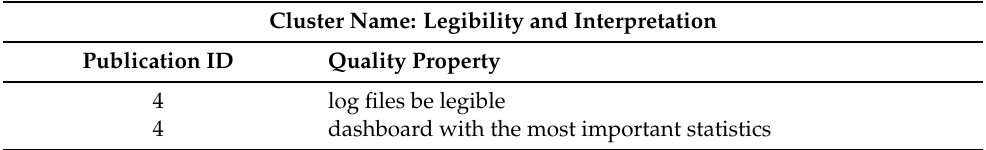
Table A8. Quality Property Cluster: Legibility and